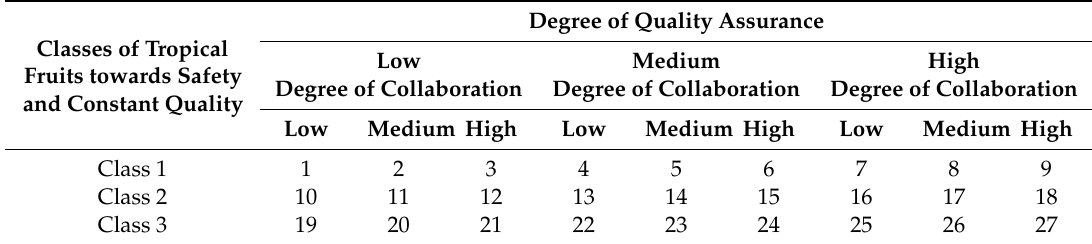
Table 4. Combination of 27 situations in the international fruit supply chain.